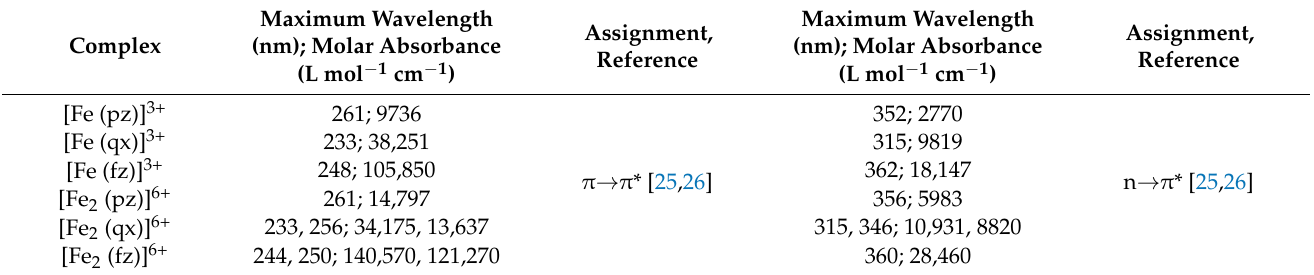
Table 2. UV-vis spectral data for the complexes [Fe (pz)] 3+ , [Fe (qx)] 3+ , [Fe (fz)] 3+ , [Fe 2 (pz)] 6+ , [Fe 2 (qx)] 6+ , and [Fe 2 fz)] 6+